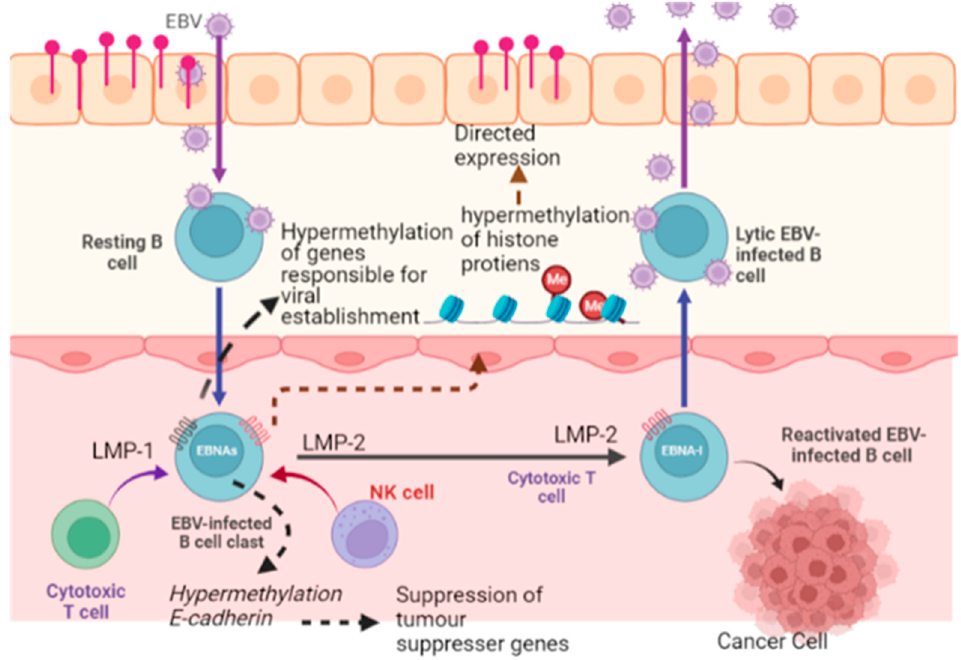
Figure 5. Transcriptional modification induced by carcinogenic viruses in the host genome causes activation of various carcinogenic genes and suppression of tumor suppression genes (Image created by biorender.com, accessed on 2 November 2022).